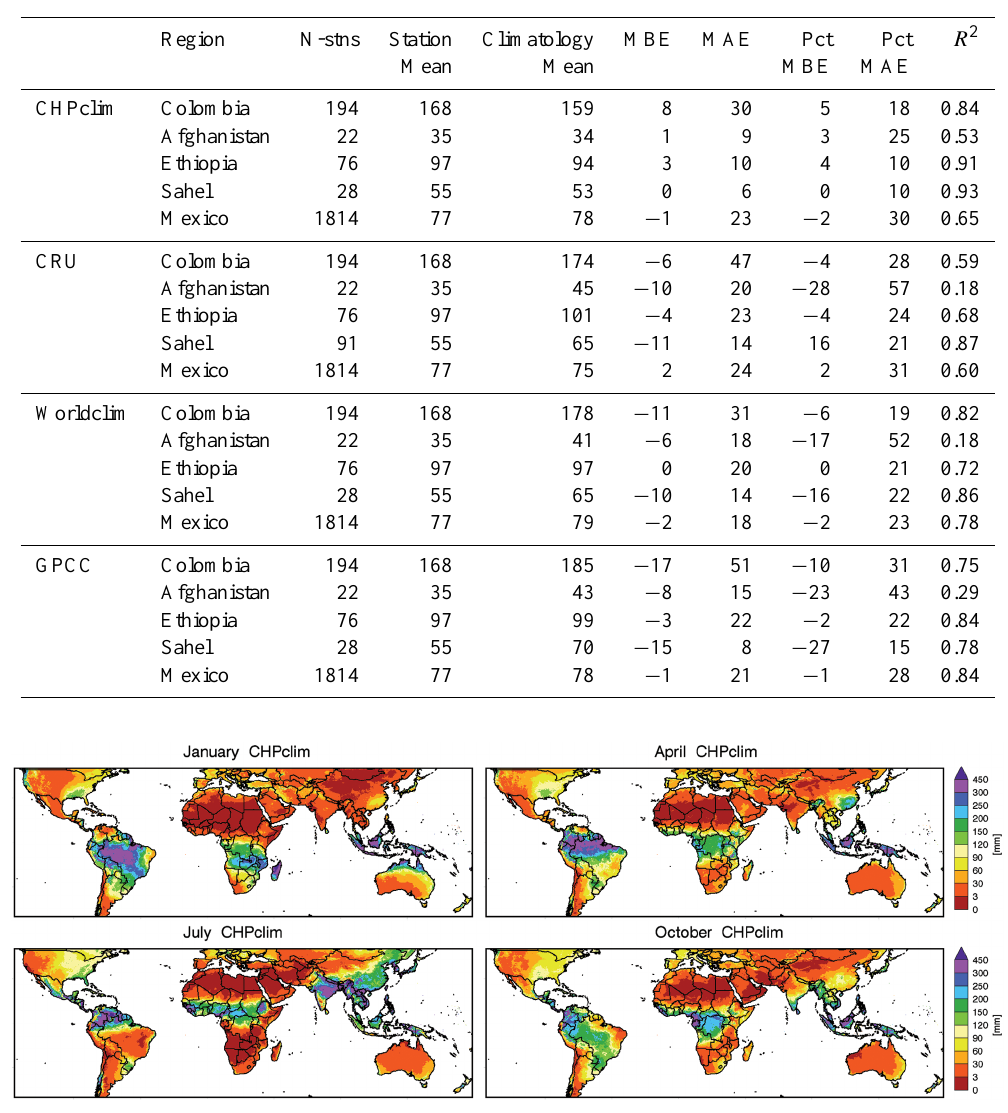
Figure 6. CHPclim monthly means for January, April, July and October. While CHPclim is global, we show 50 ◦ S–50 ◦ N images to facilitate